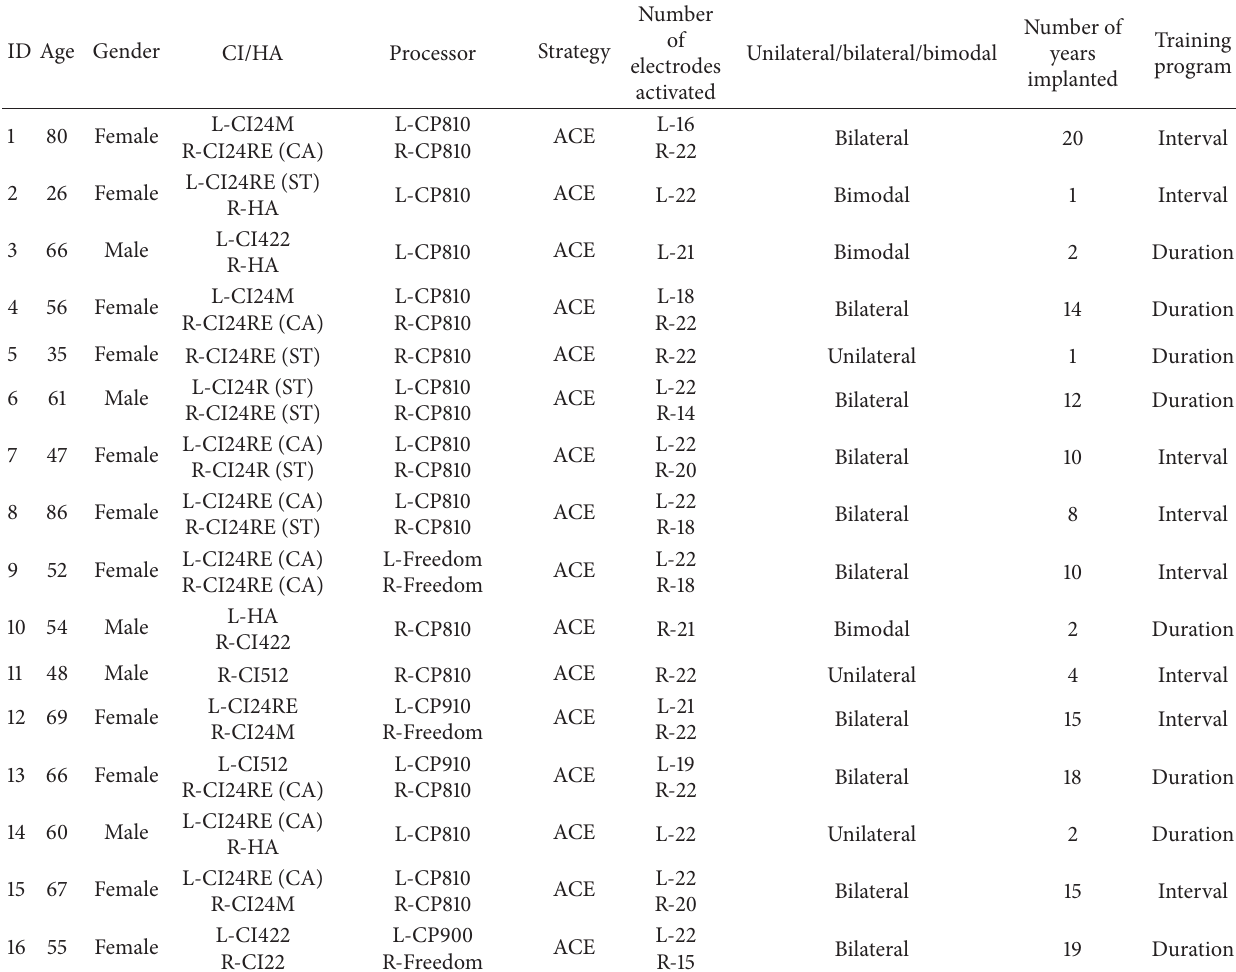
Table 1: Demographic information for Cochlear implant (CI)